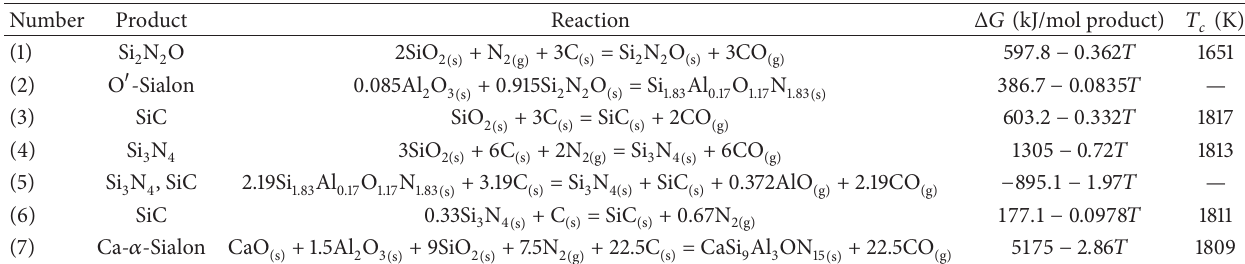
Table 3: Expressions for Gibbs free energy of some net reactions.